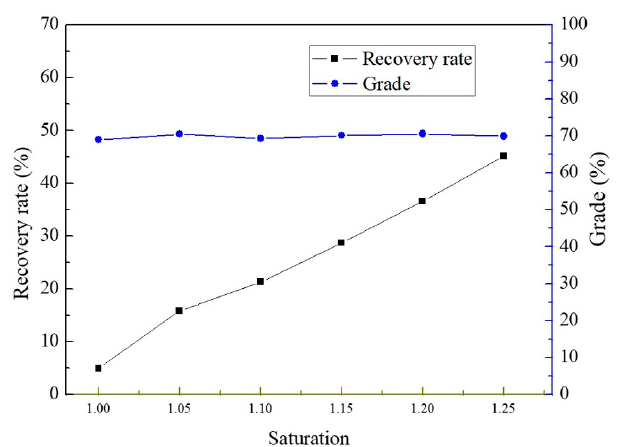
Figure 5. Recovery rate and grade of crystals produced by MD integrated with crystallization process at different saturation values.